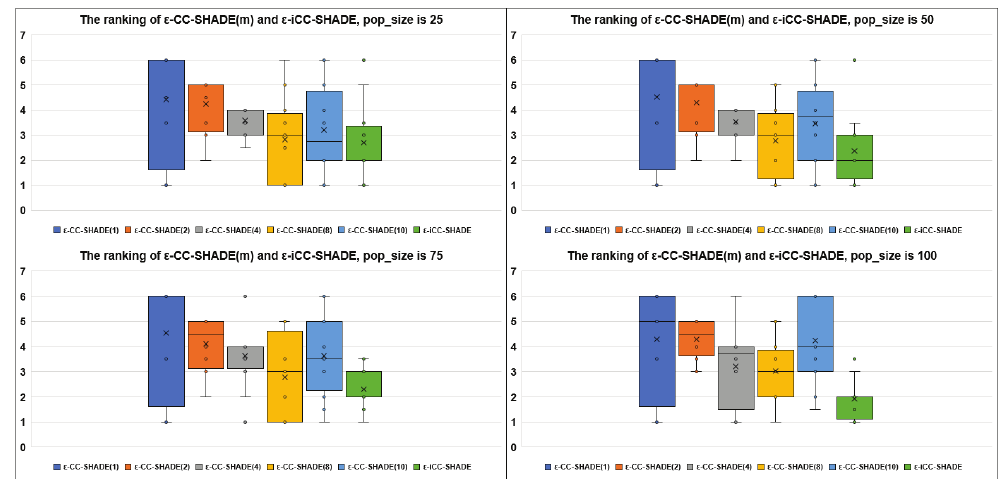
Figure 3. The ranking of ε -CC-SHADE (m) and ε -iCC-SHADE on separable problems. Figure 3. The ranking of (cid:905) -CC-SHADE (m) and (cid:905) -iCC-SHADE on separable problems. Figure 3. The ranking of (cid:905) -CC-SHADE (m) and (cid:905) -iCC-SHADE on separable problems.